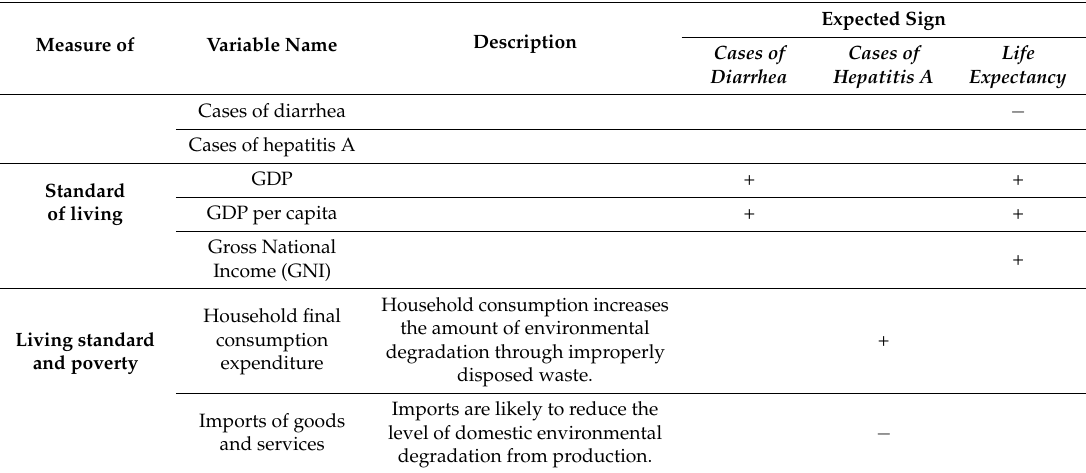
Table 1. Description of the variables